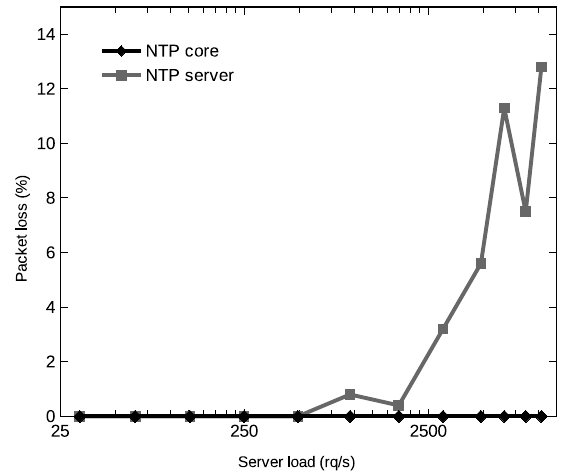
Figure 20. NTP servers missed requests percentage vs. network